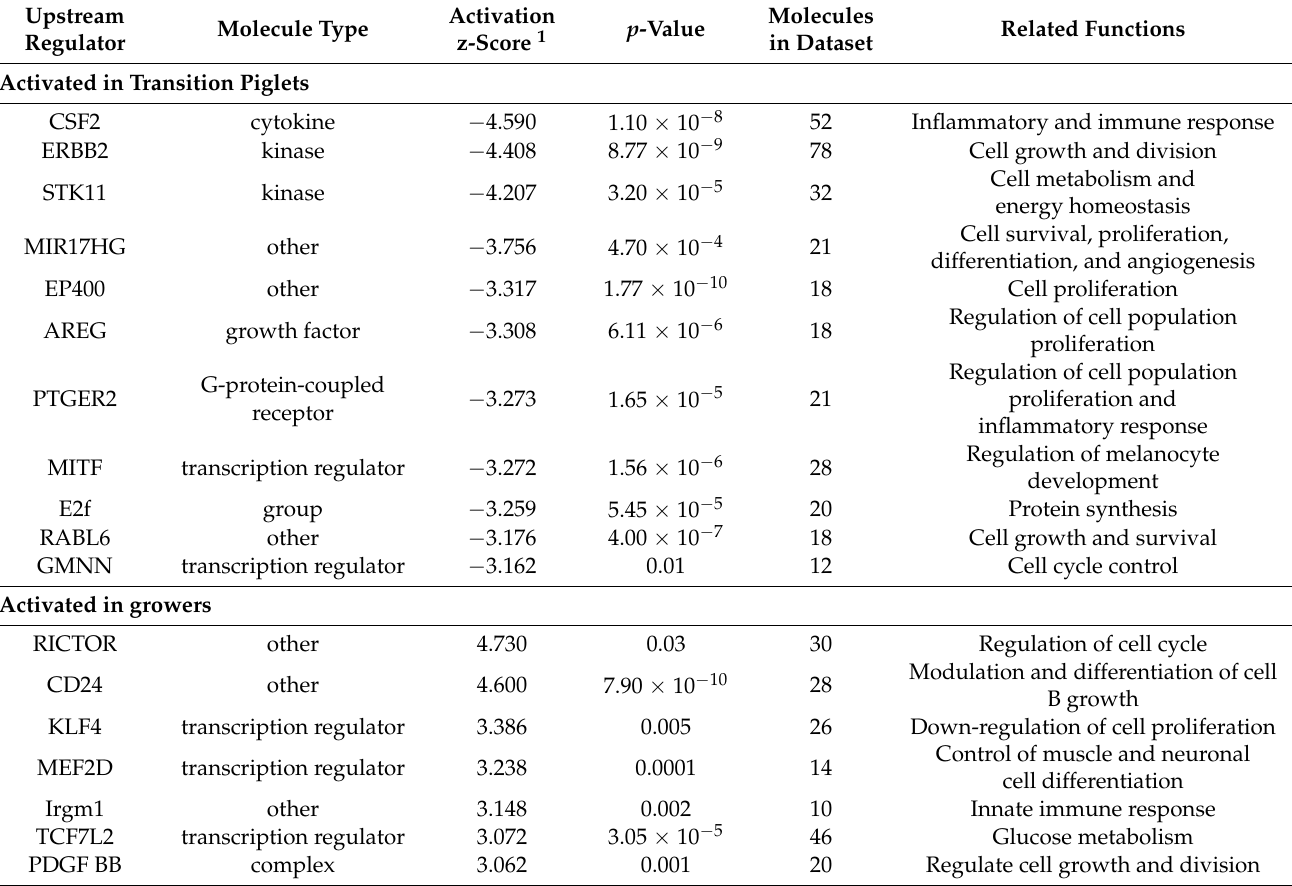
Table 4. Most relevant activated upstream regulators (sorted by z-score) for the set of DEGs according to age ( p -value < 0.05 and z-score > 3 or < −